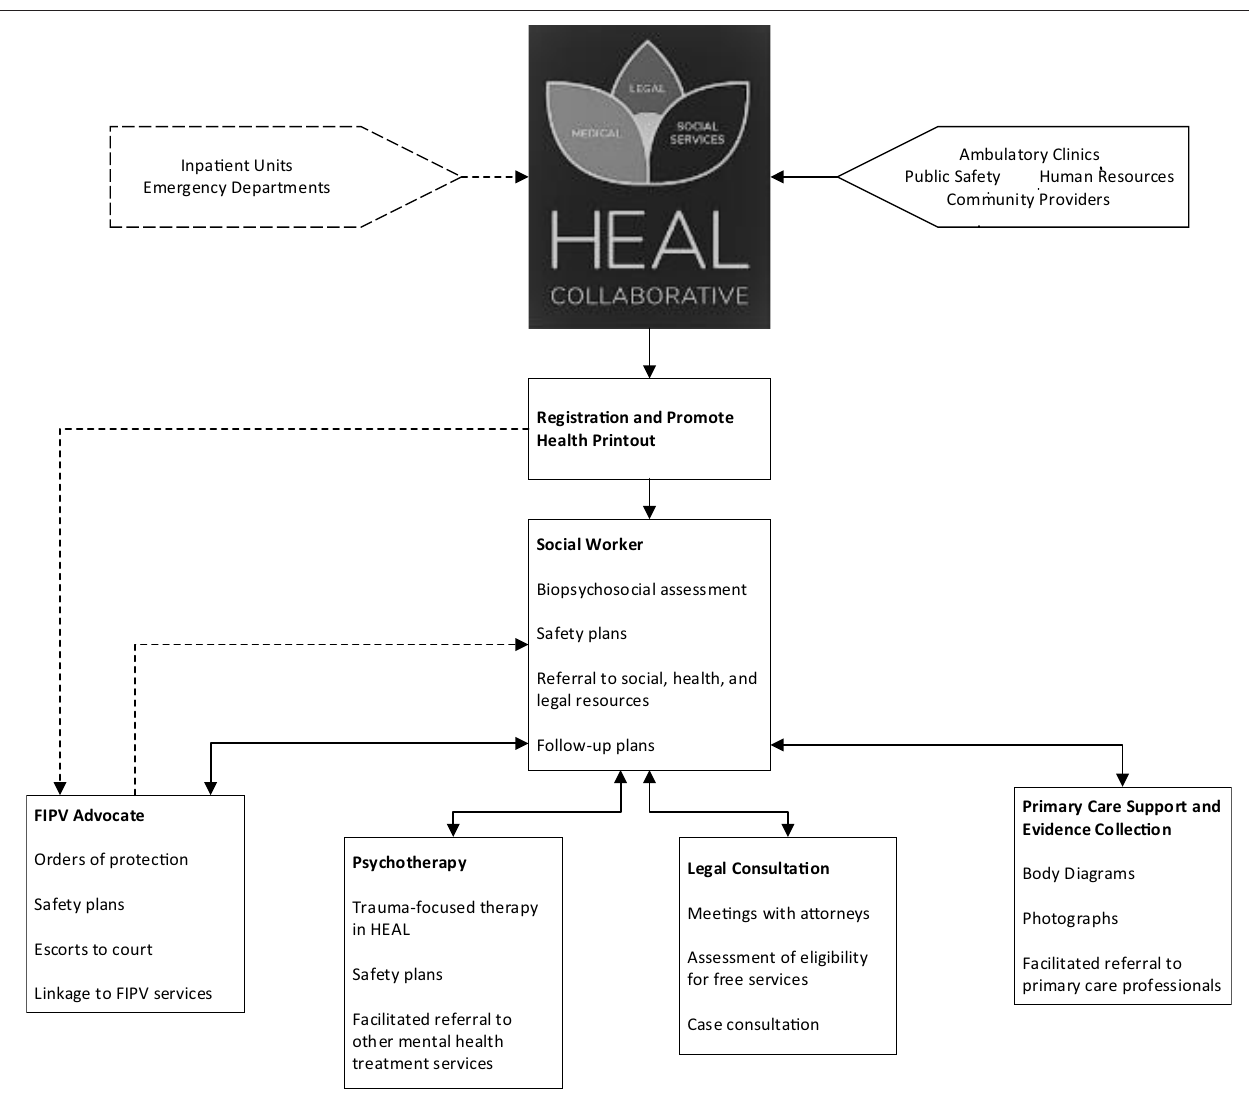
center. We serve patients without regard to race, ethnicity, gender identity, or sexual orientation. Youth are directed to our local children’s program although we work with caregivers and families. Presenting concerns range from patients who are hospitalized due to injuries caused by their partner and wanting to prevent future contact to those beginning to explore abuse in their relationships to individuals who may be safe currently but have an unresolved history of abuse. The team has a secure suite of offices within an urban hospital and is mobile within the hospital to meet individuals in crisis in the emergency department or on inpatient units. HEAL staff follow-up with ambulatory care after discharge. The HEAL consultation service ranges from urgent calls when a professional is fearful of allowing an individual to leave with a partner, caring for an individual not yet ready or able to come to HEAL, informational calls